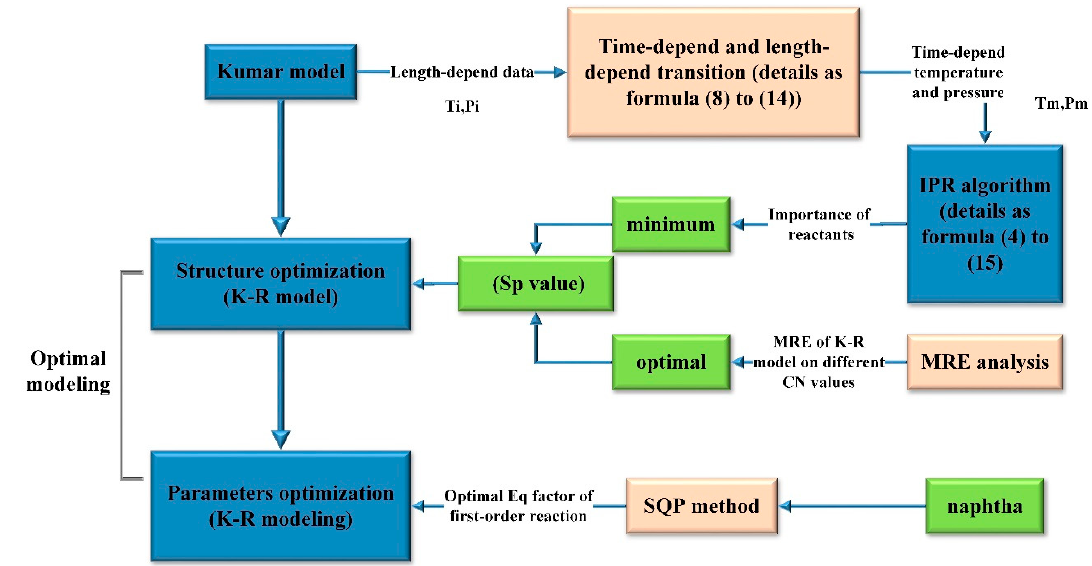
Figure 3. Flowsheet of modeling in K-R model.